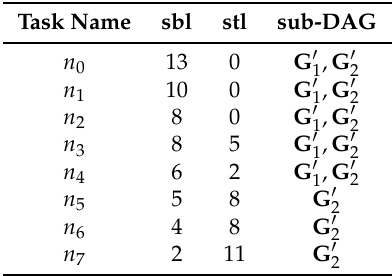
Table 2. Task priorities and graph partitioning of the example DAG. sbl, static bottom level; stl, static top